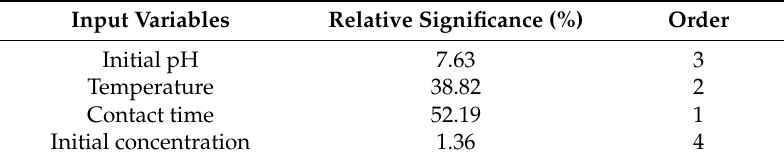
Table 5. Relative significance of input